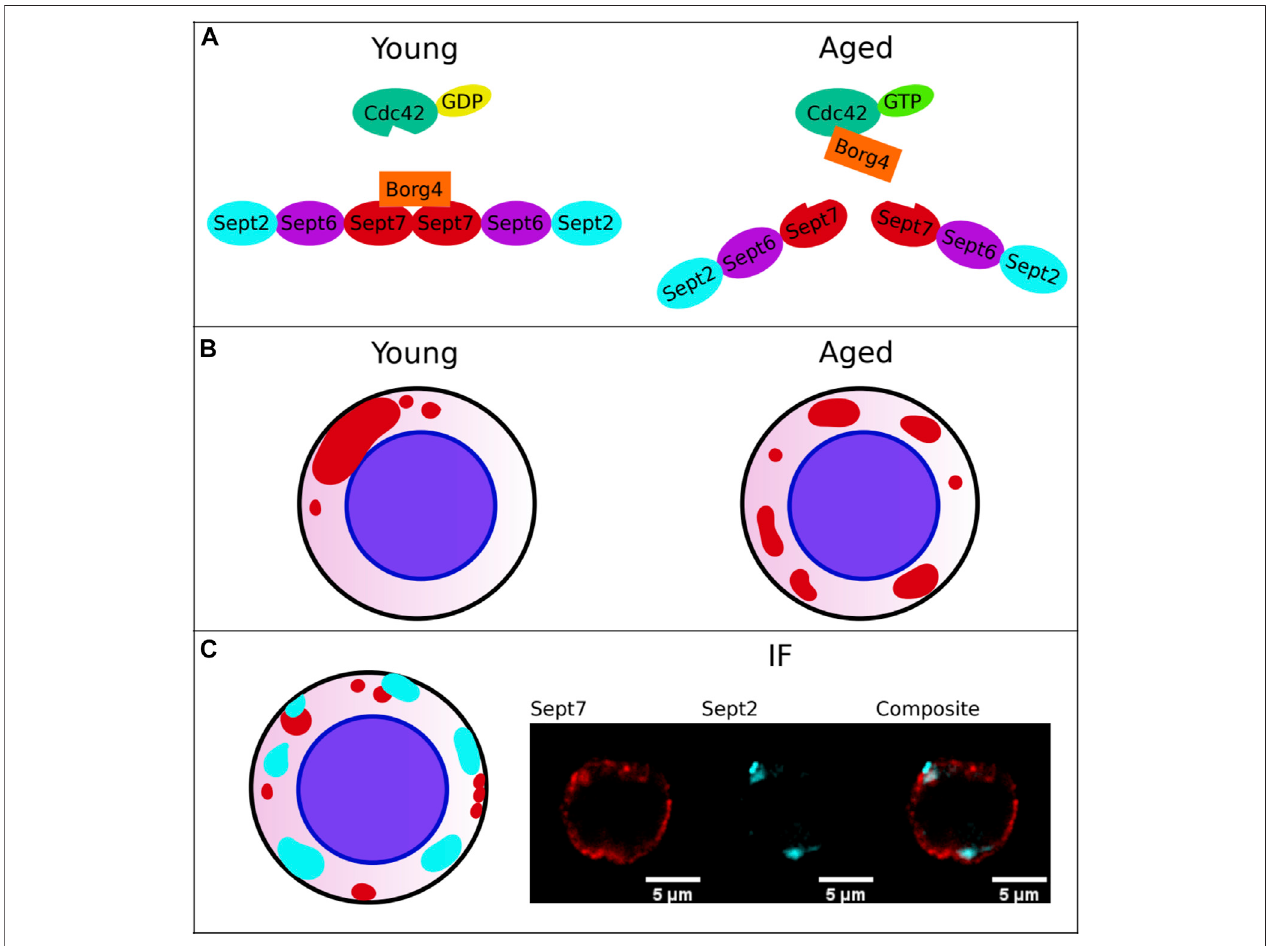
FIGURE 1 | Septin behavior in hematopoietic stem cells (HSCs). (A) Change in Cdc42-Borg4-Sept7 axis upon aging. Interaction of Borg4 with Sept7 is shifted upon aging according to elevated activity level of Cdc42 to interaction of Cdc42 with Borg4. (B) Change in protein distribution of Sept7 upon aging: Elevated Cdc42 activity leads to a more apolar distribution. (C) Interaction of Septins among themselves. Sept7 and Sept2 don ’ t show same distribution. The Septin Network is more complex and demands further studies.